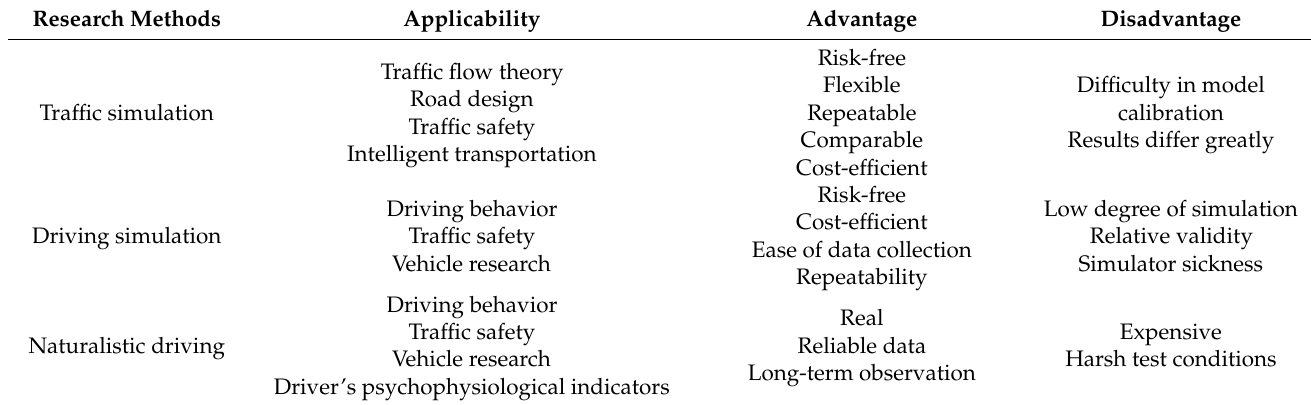
Table 1. Comparison of the advantages and disadvantages of research methods in the work